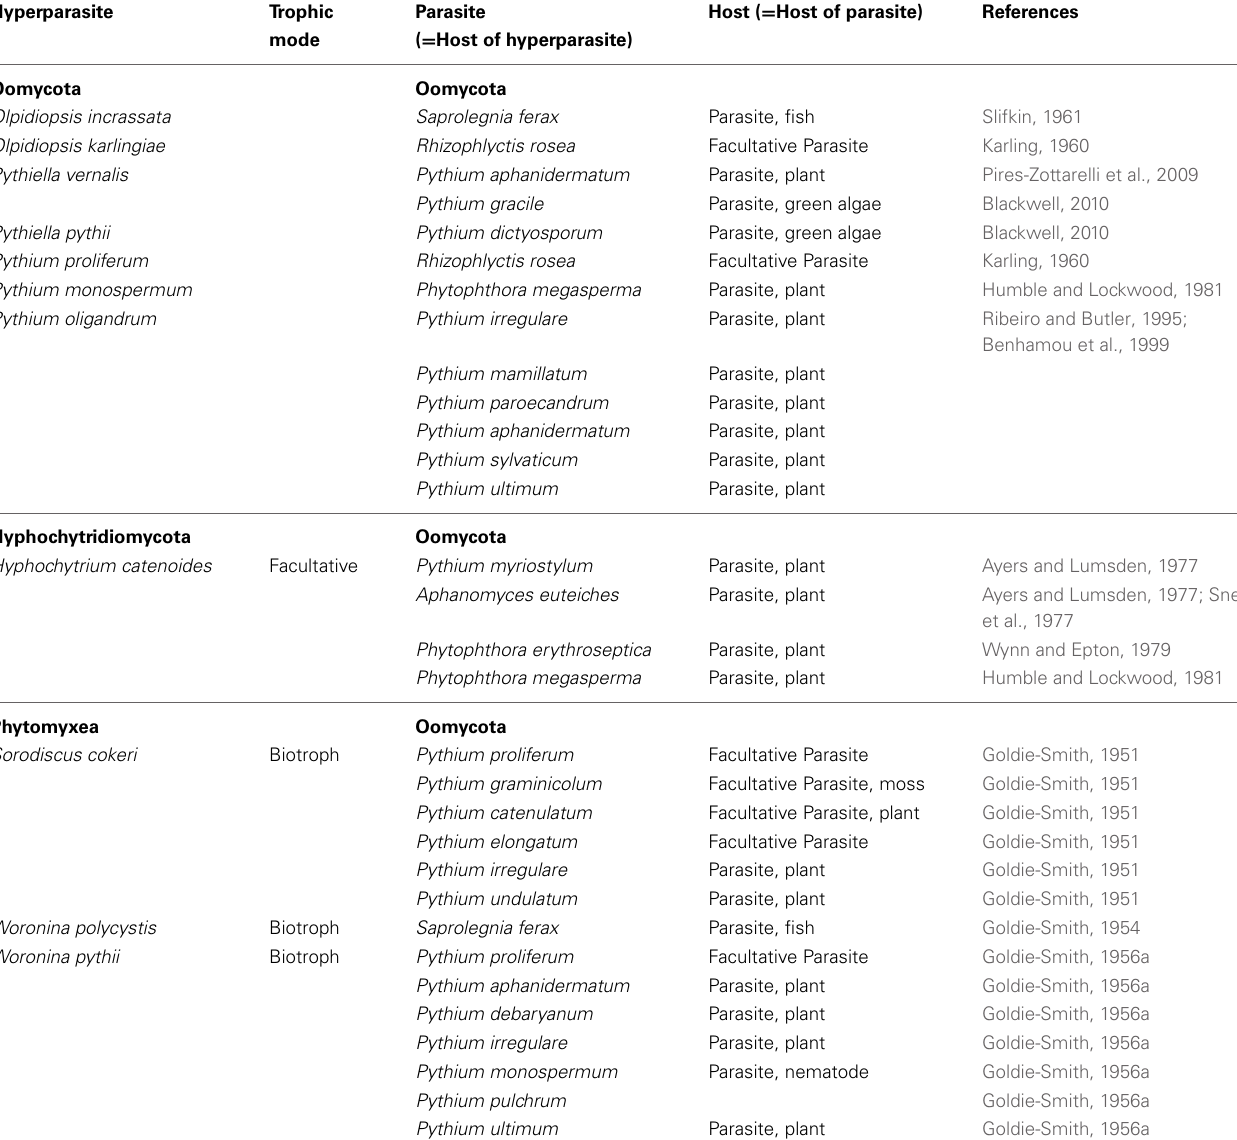
Table 2 | Selected hyperparasitic Heterokonts (Oomycota, Hyphochytridiomycota,